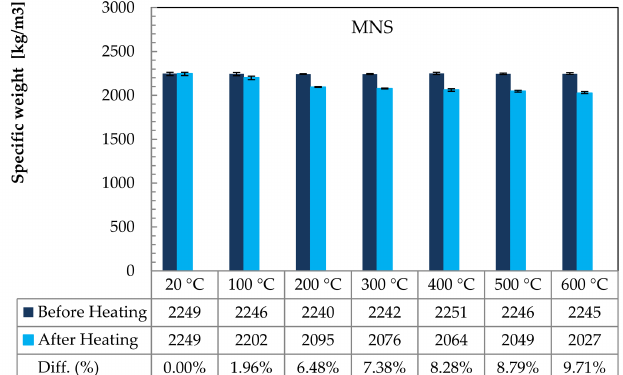
Figure 4. Weight loss due to thermal treatments for the normal strength mortar MNS.